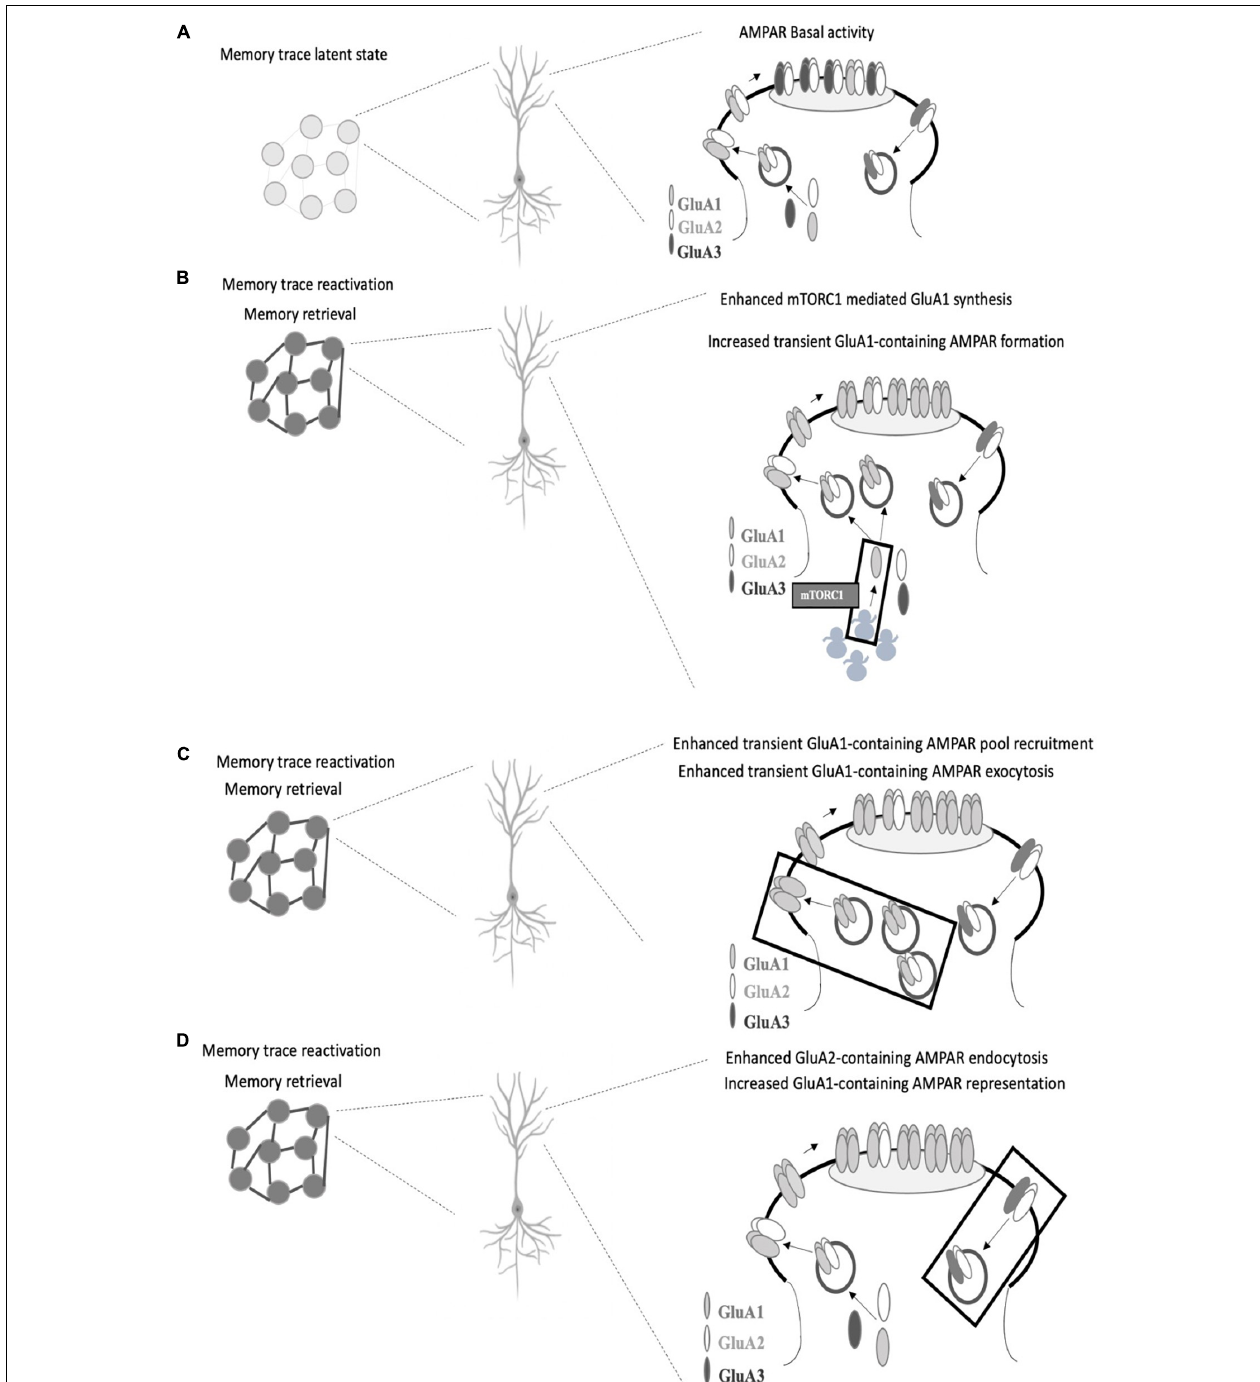
FIGURE 1 | Proposed AMPAR events associated with memory retrieval. (A) In a memory trace latent state, GluA1-containing AMPAR are not enough represented at the postsynaptic density and memory recall does not take place. (B) GluA1 subunit synthesis is needed for memory retrieval to occur (mediated by mTORC1 pathway as we previously reported), which could favor transient GluA1-containing AMPAR formation (especially GluA1 homomers AMPAR) and surface expression which replaces GluA2-containing AMPAR in the postsynaptic density. (C) Alternatively, enhanced GluA1-containing exocytosis may occur in response to activity regulated GluA1-containing AMPAR recruitment. (D) Regulated levels of GluA2-containing AMPAR endocytosis may also account for a greater representation of GluA1-containing AMPAR at the synapse. In all the cases, the proposed AMPAR subunit point alterations lead to GluA2 to GluA1 subunit composition shift during memory retrieval. GluA2 synthesis is also required for memory retrieval although GluA2-containing AMPAR seem to have a support role at the time of retrieval.